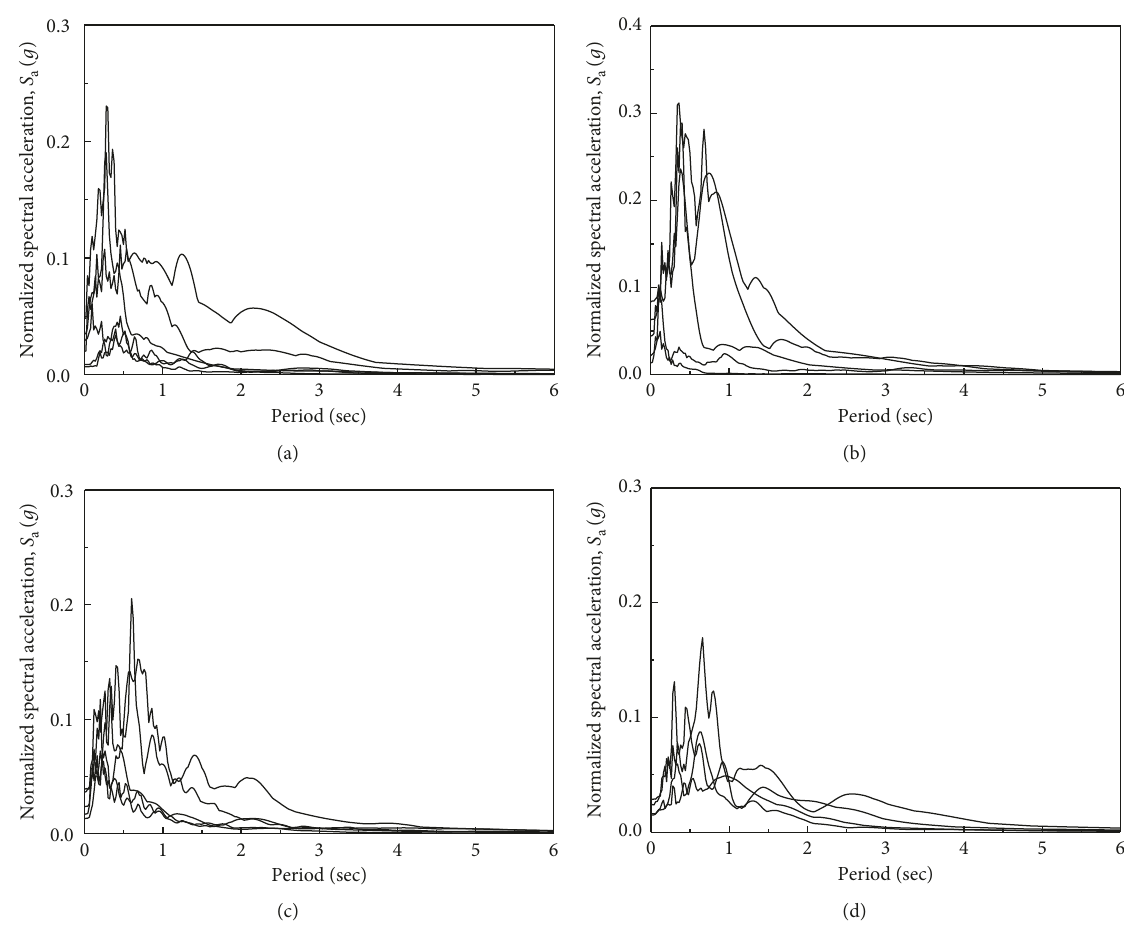
Figure 10: Normalized spectral acceleration for four ground sites. (a) Ground site, I (b) ground site II, (c) ground site III, and (d) ground site